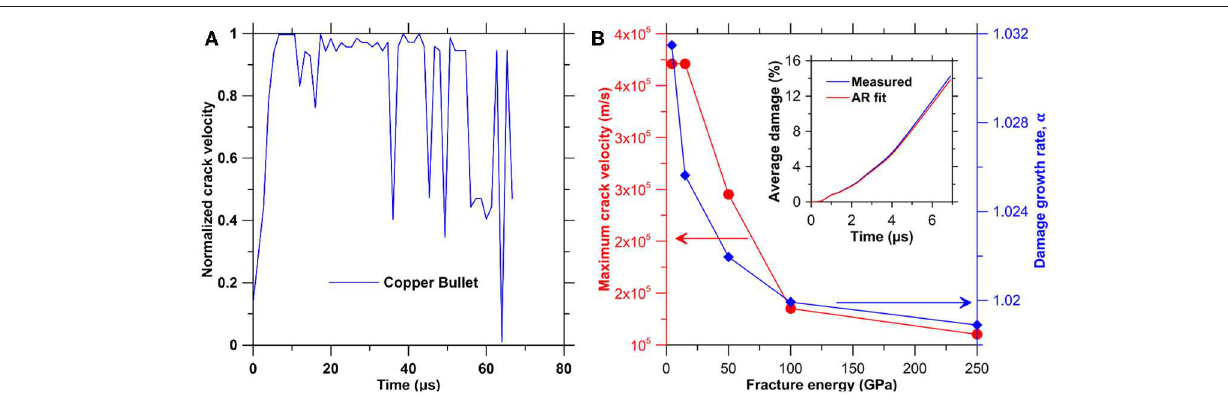
FIGURE 9 | (A) Evolution of normalized crack velocity of a major radial crack in a glass plate with a fracture energy 4.3 J/m 2 for a copper bullet. Note that the crack velocity is normalized with respect to the maximum crack velocity during the propagation of the crack. (B) Maximum crack velocity (left axis) and damage growth rate (right axis) with respect to the fracture energy of the glass plate. INSET shows the AR fit compared to the measured evolution of damage in peridynamic simulation of impact on a glass plate with fracture energy 4.3 J/m 2